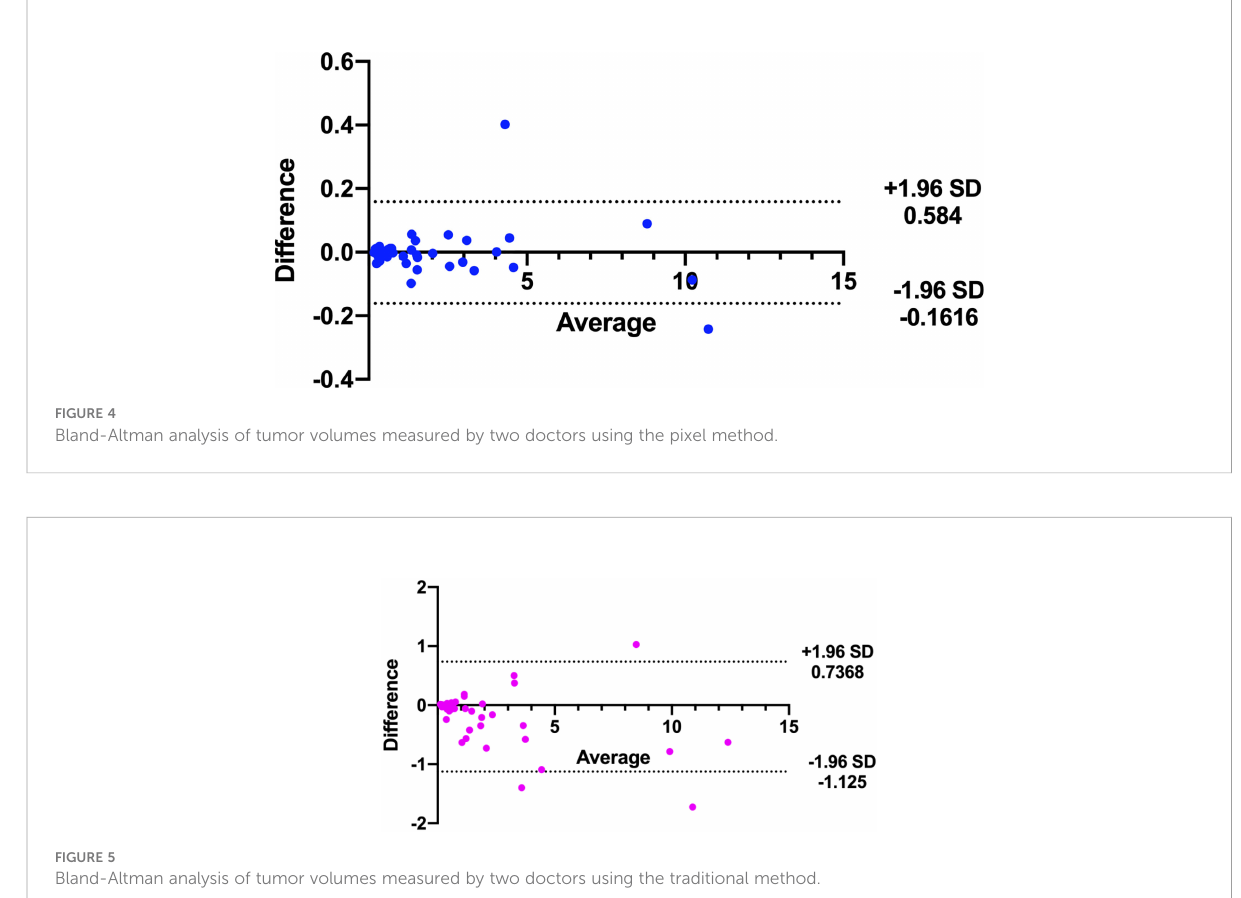
TABLE 2 Comparison between the difference of tumor volumes measured by two physicians using either the pixel or traditional method.